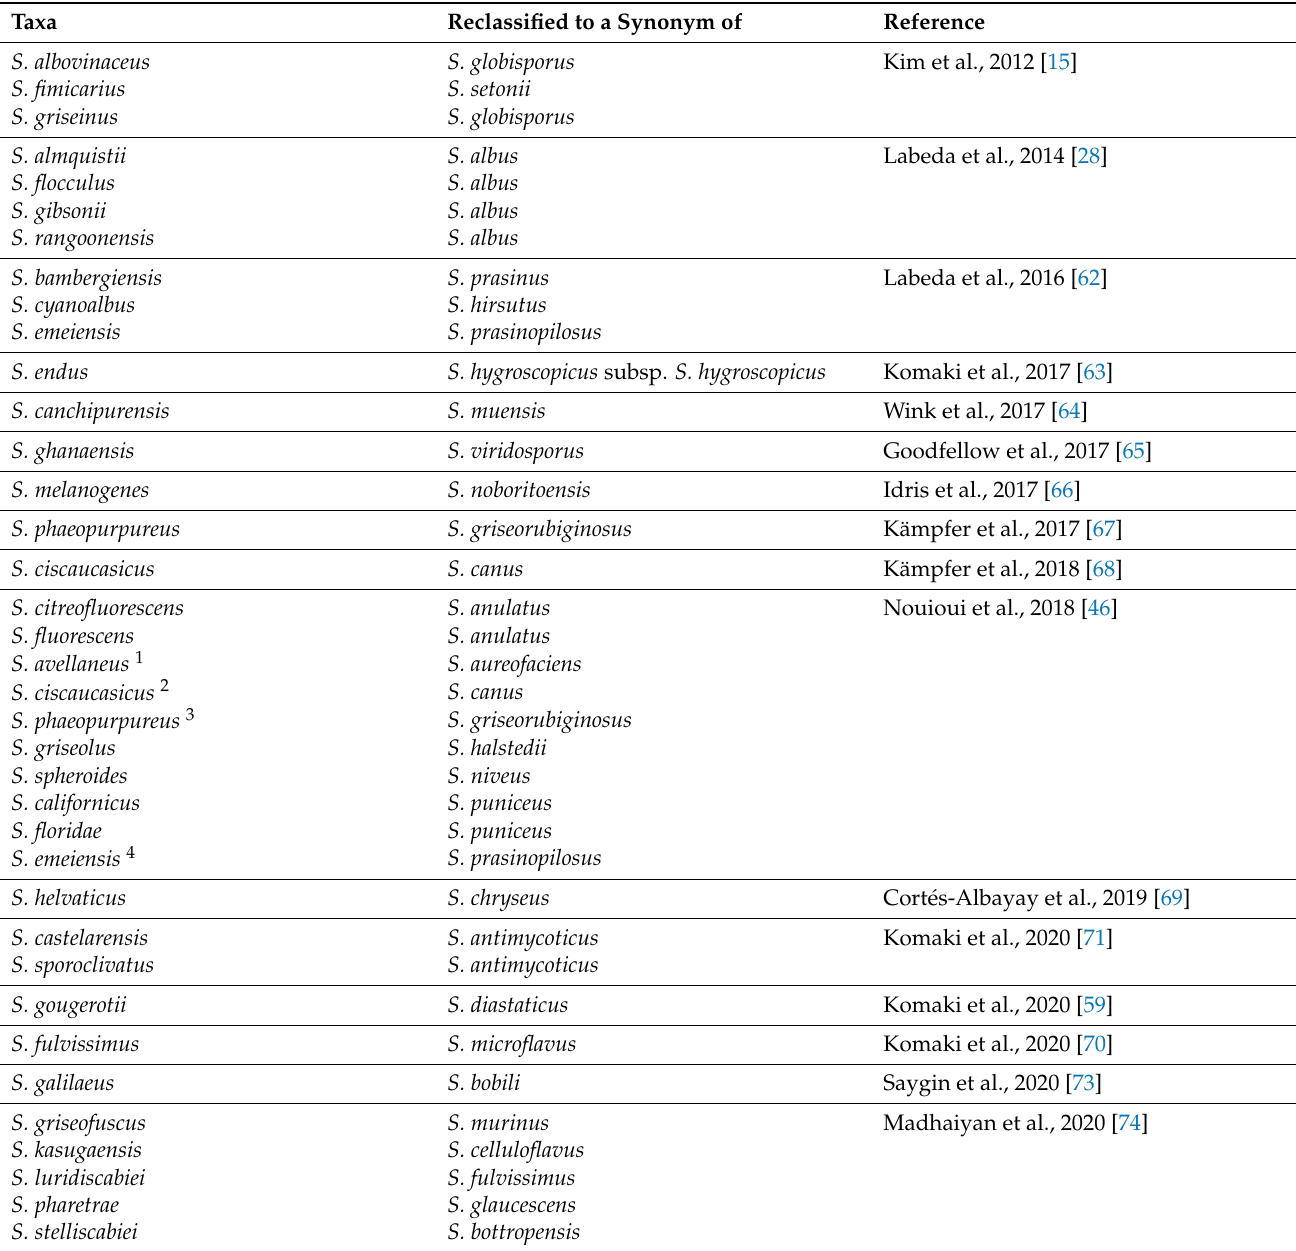
Table 3. Reclassified taxa as later heterotypic